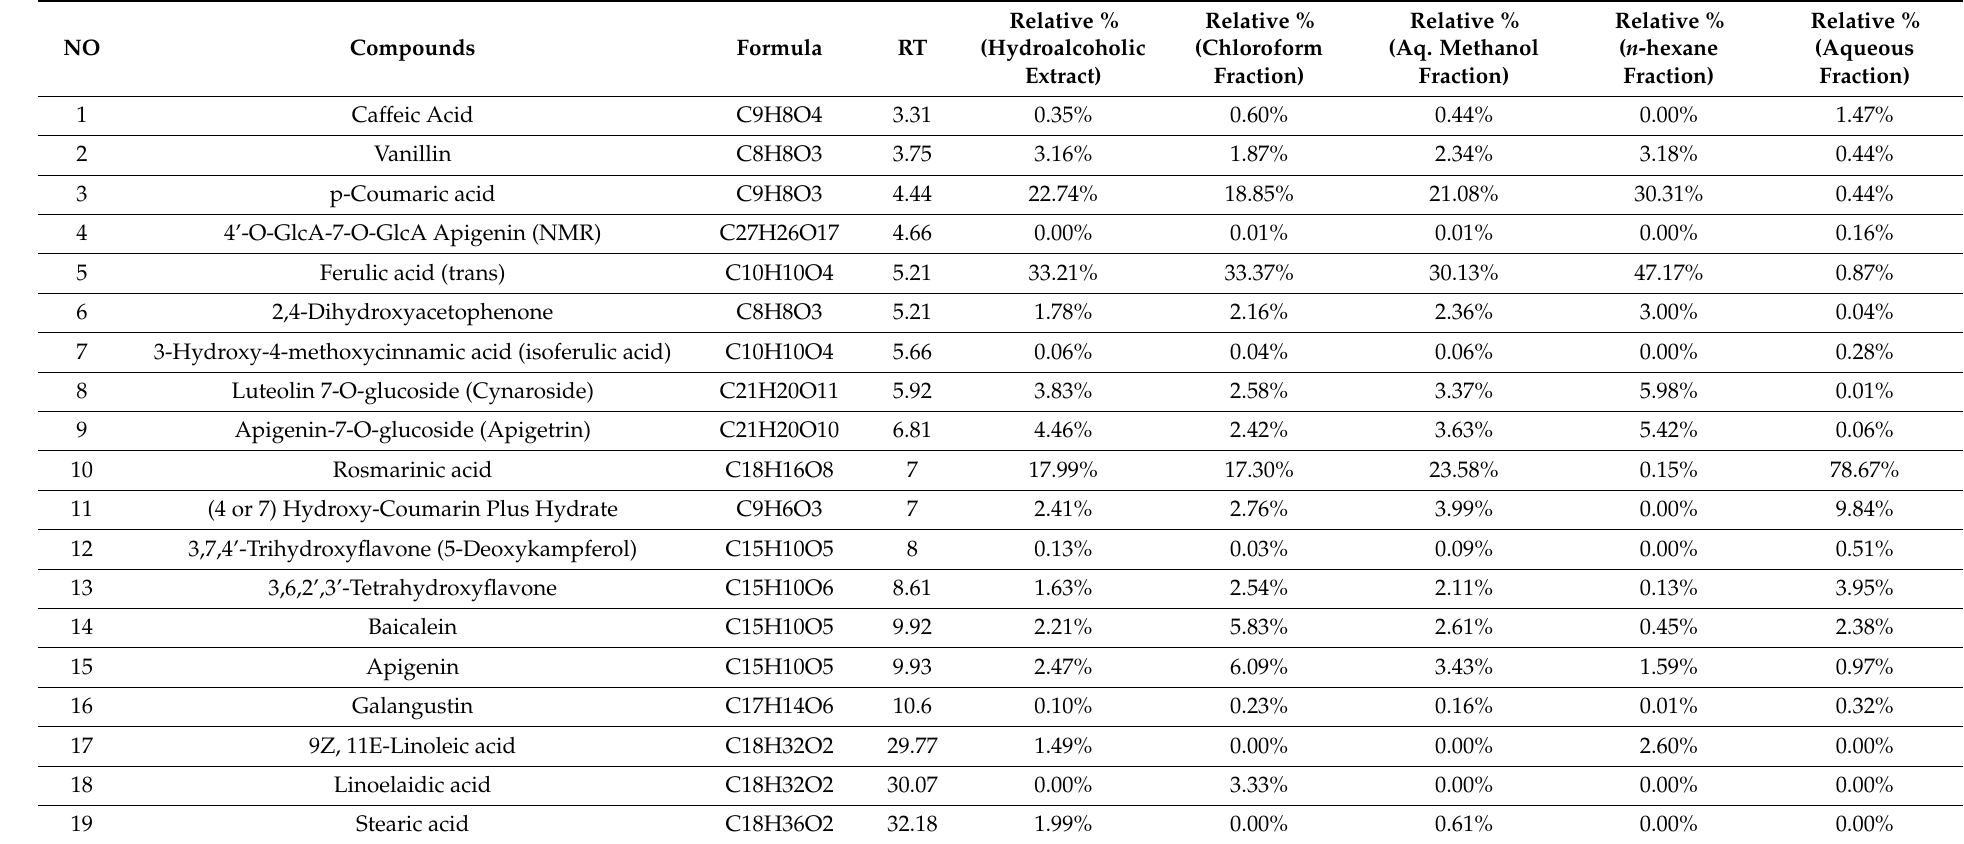
Table 3. LC–MS analysis results of H. orientalis L. extract and